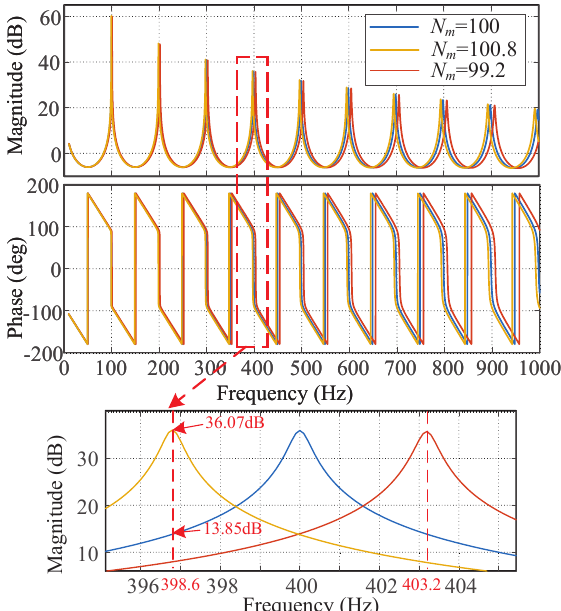
Figure 4. The frequency characteristics of MRC ( N m = 100) and FOMRC ( N m = 100.8,